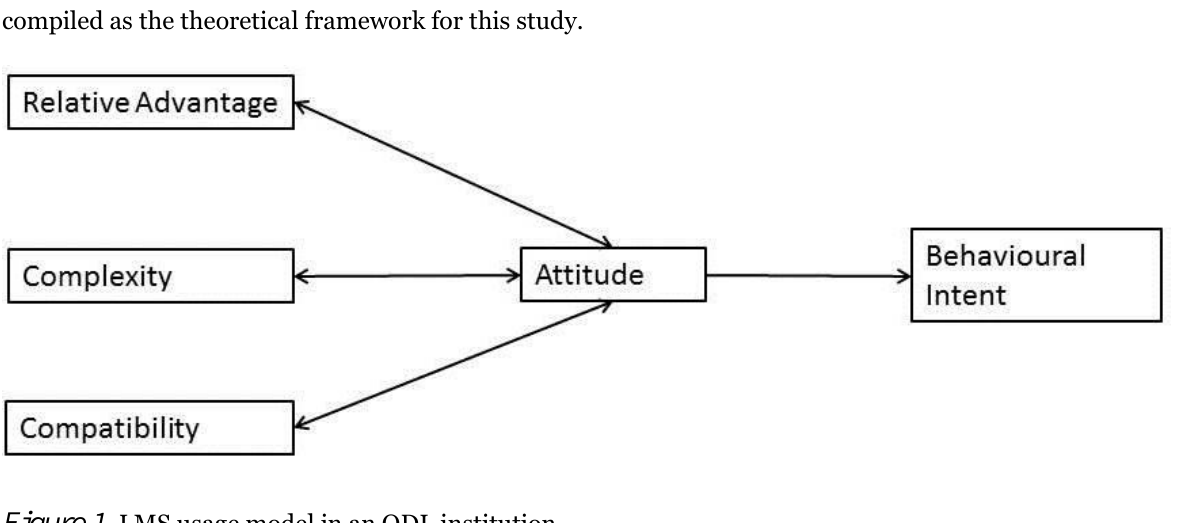
Figure 1 . LMS usage model in an ODL